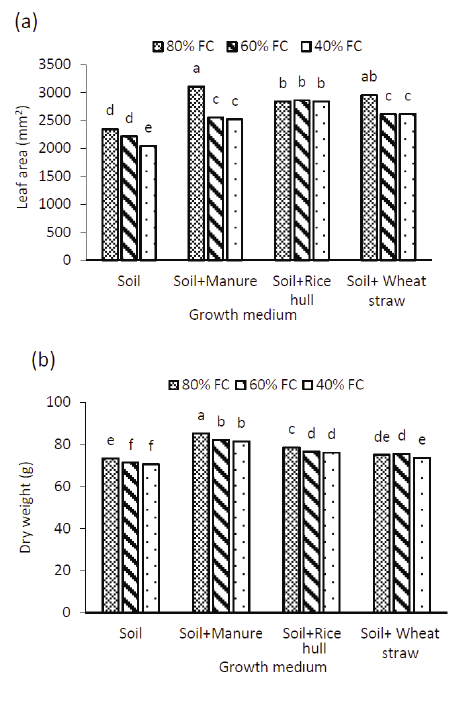
Fig. 6 ­ Leaf area (a), and dry weight (b) in hollyhock plants under different medium. Values in columns followed by the same letter are not significantly different at the 0.05 level